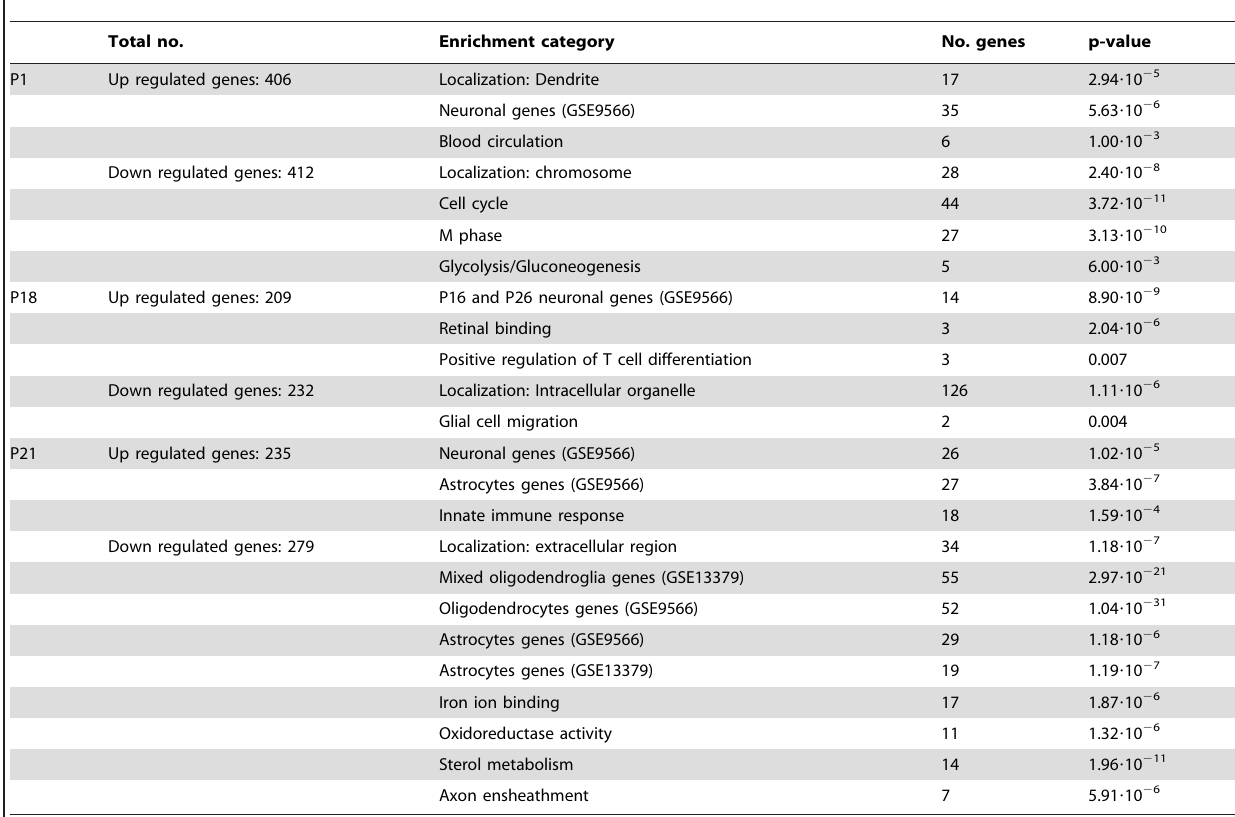
Table 1. Enrichments of co-annotated genes among the differentially expressed genes.